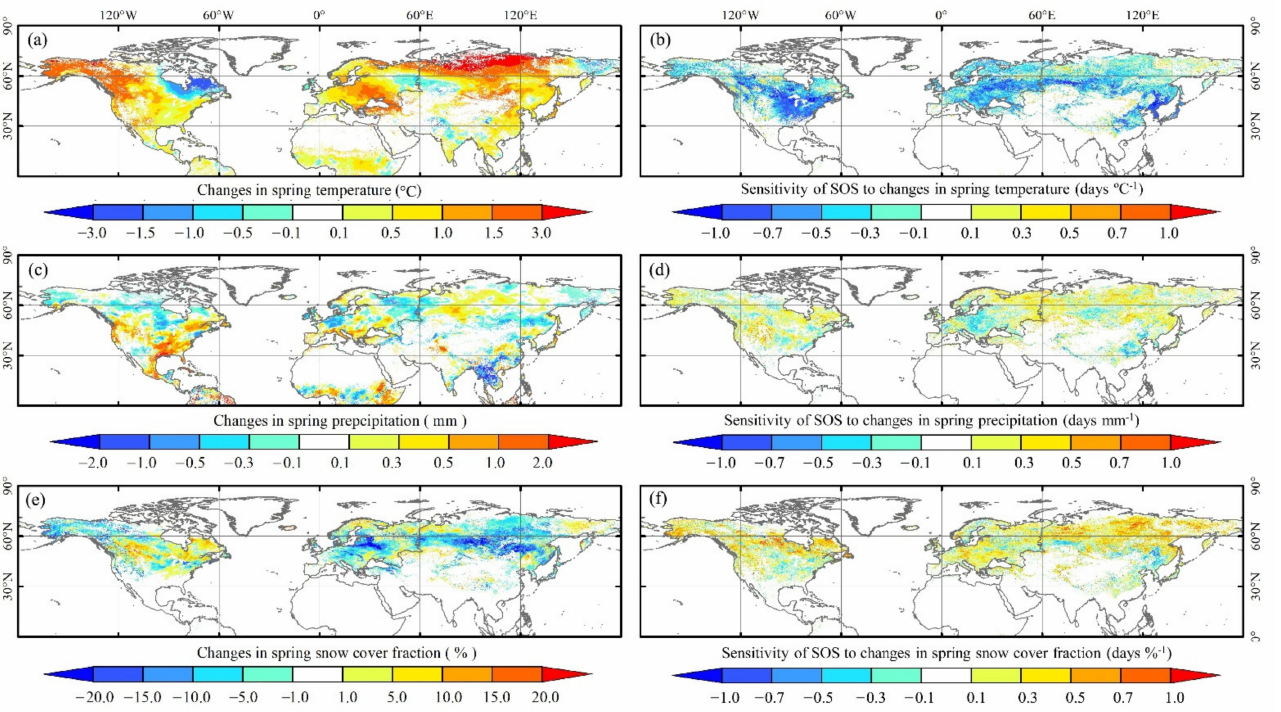
Figure 5. The 18-year changes in ( a ) T s , ( c ) P t , and ( e ) S c over the NH for 2001–2018 and sensitivity of the SOS to changes in ( b ) T s , ( d ) P t , and ( f ) S c over the NH for